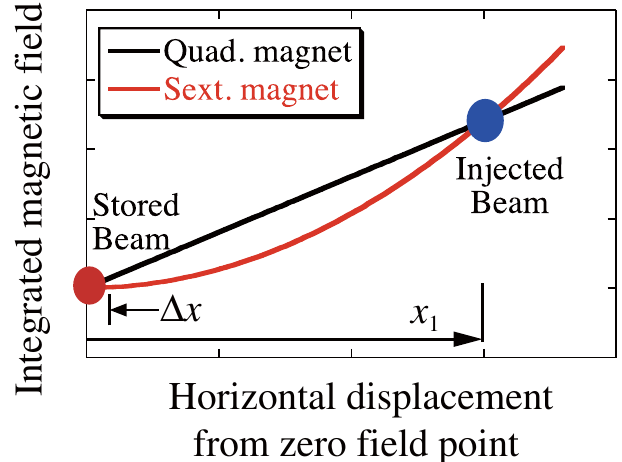
ffiffiffiffiffiffiffiffiffiffiffiffiffiffiffiffiffiffiffiffi